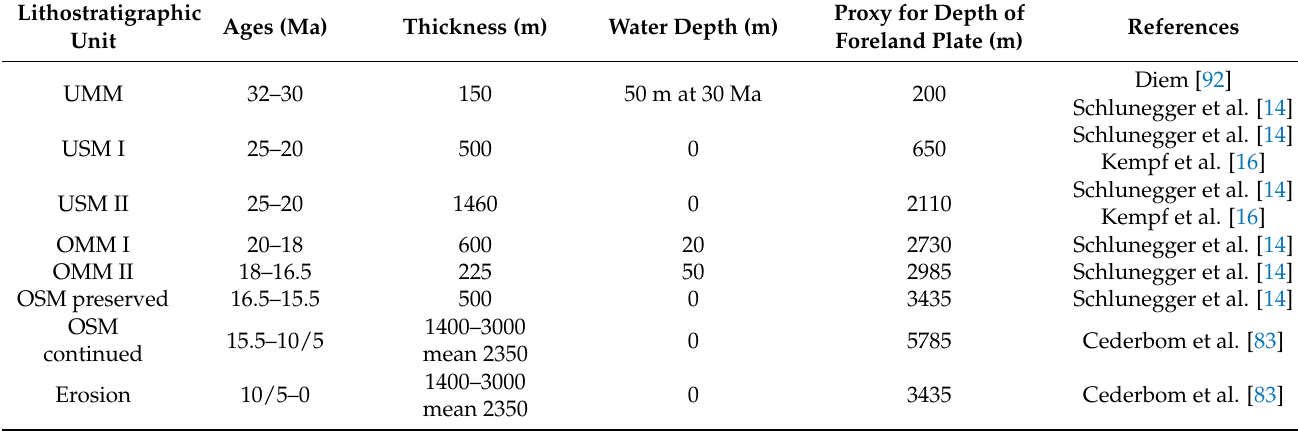
Table 2. Source information that was used to calculate the subsidence pattern of the foreland plate underlying the Swiss part of the Molasse basin near Lucerne (see site labelled as S in Figure 2